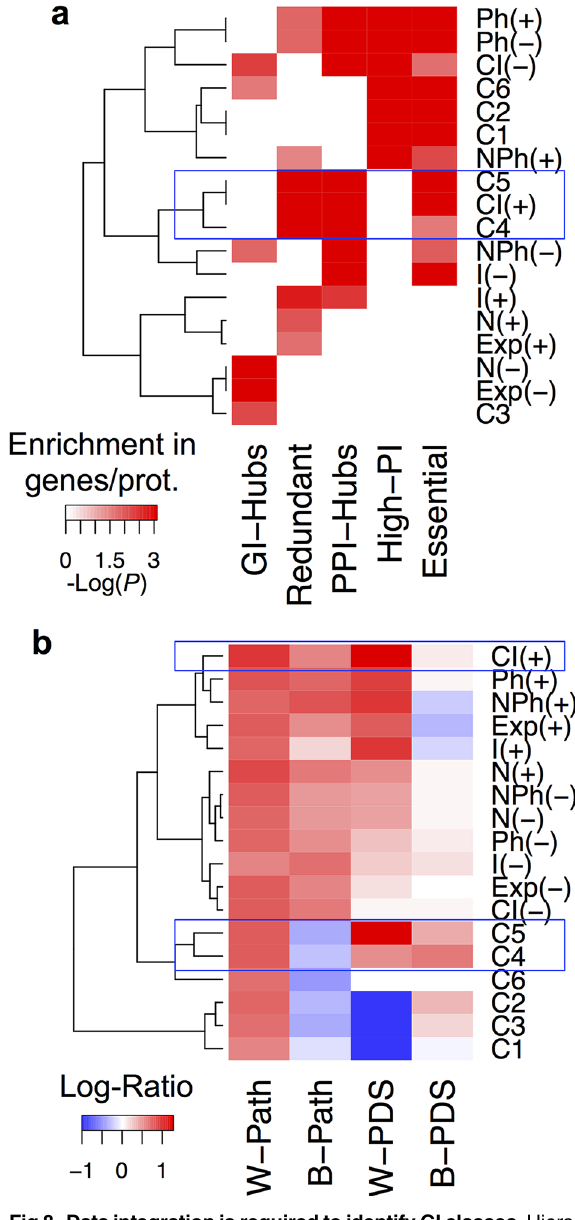
Fig 8. Data integration is required to identify GI classes. Hierarchical clustering of (a) Enrichment in GI classes and GI groups of Genetic interaction-Hubs (GI-Hubs), redundant genes, protein-protein interaction- Hubs (PPI-Hubs), Highly pleiotropic genes (High-PI) and essential genes -log of P-values from Fisher ’ s exact test are indicated. GI groups are associated to a positive value (+; above a threshold) or a negative value (-; below the threshold) for indicated attributes. Threshold values for each attributes are indicated S6 Table. (b) Log-Ratios profiles for GI classes and GI groups associated to a positive (+) or a negative (-) values for indicated attributes. Blue boxes indicate enrichment of biological characteristics for C4 and C5 GI classes and CI(+) GI group.